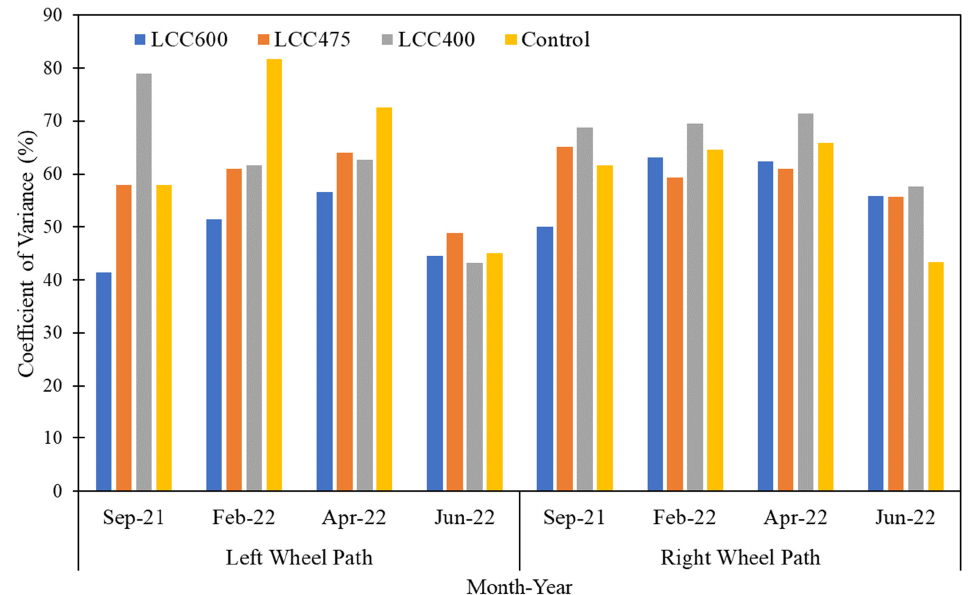
Figure 14. Notre Dame Drive Southbound Lane measured Coefficient of Variance. Table 3. Notre Dame Drive mean IRI.